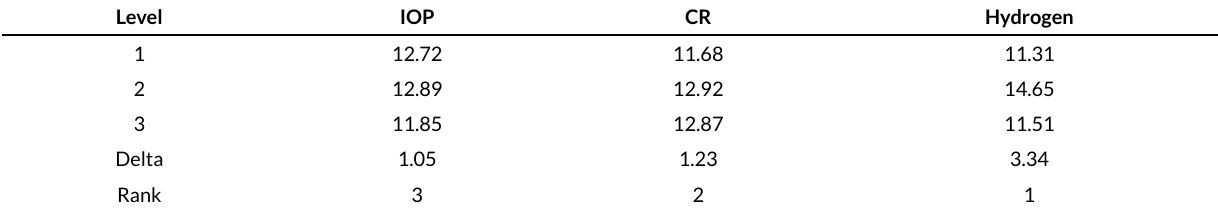
TABLE 6. ANOM OF UTILITY S/N VALUES